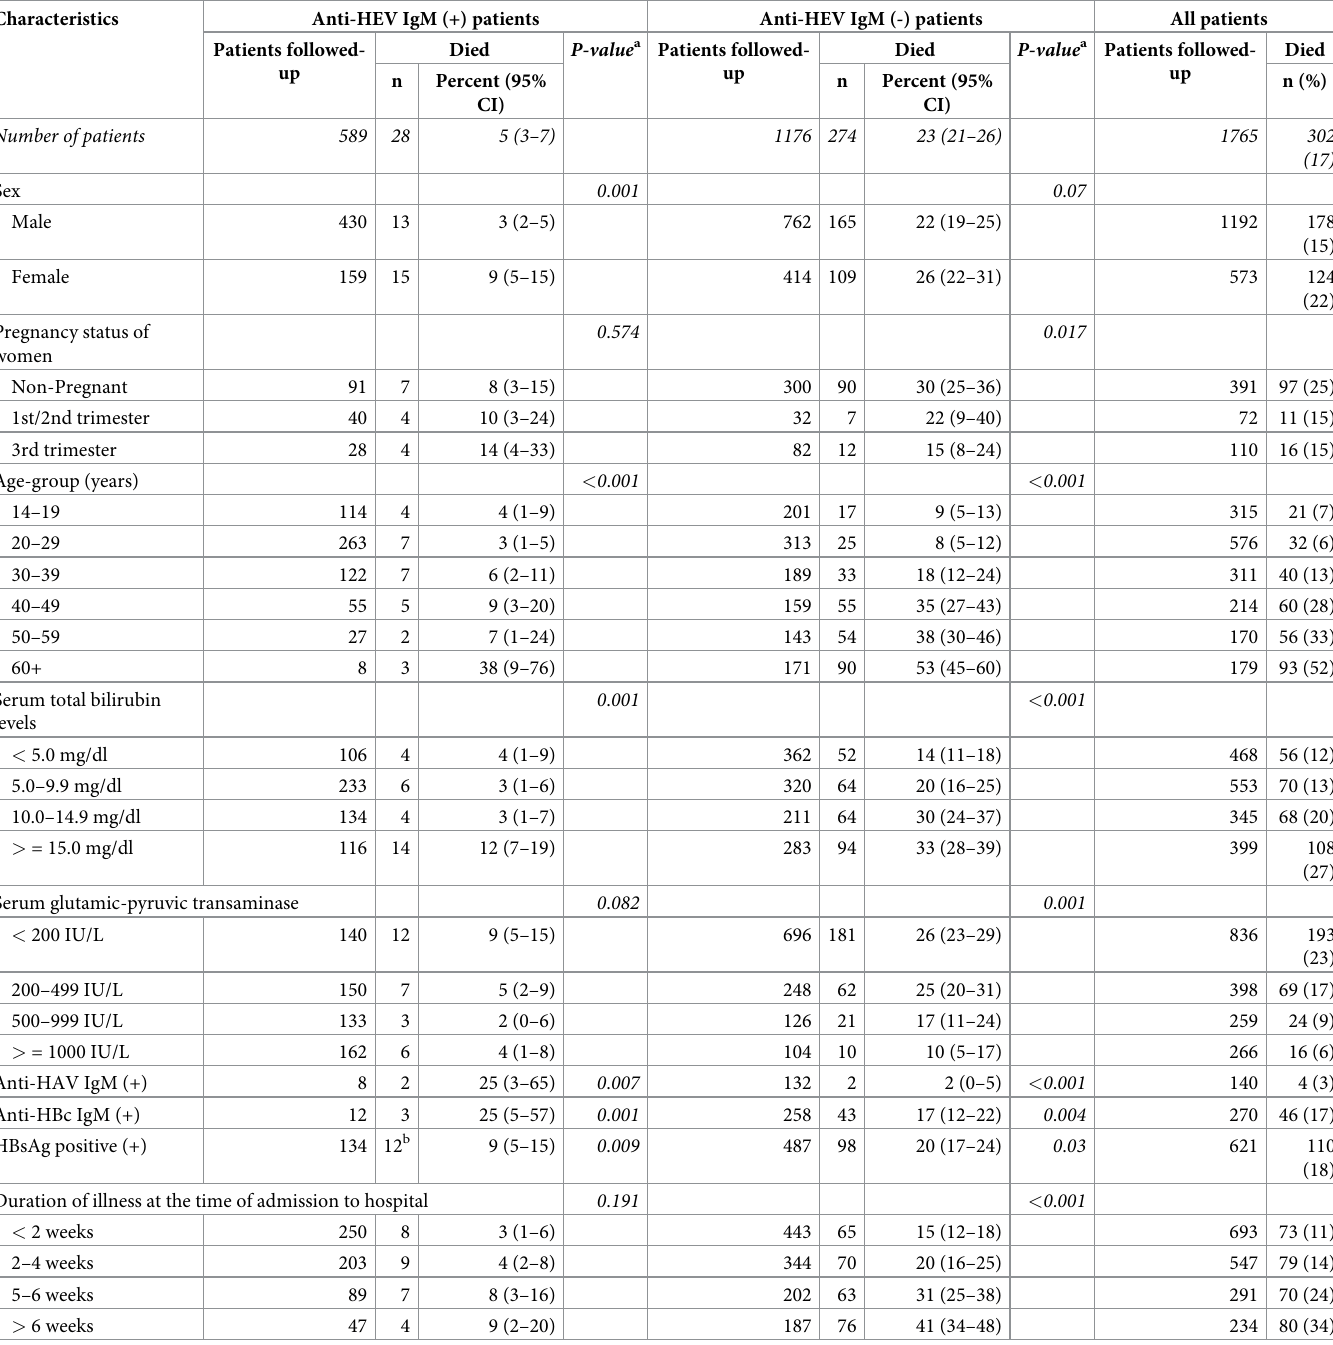
Table 3. Survival status of patients with acute jaundice admitted in six tertiary hospitals in Bangladesh, December 2014-September 2017 (patients followed-up 3 months post hospital discharge).